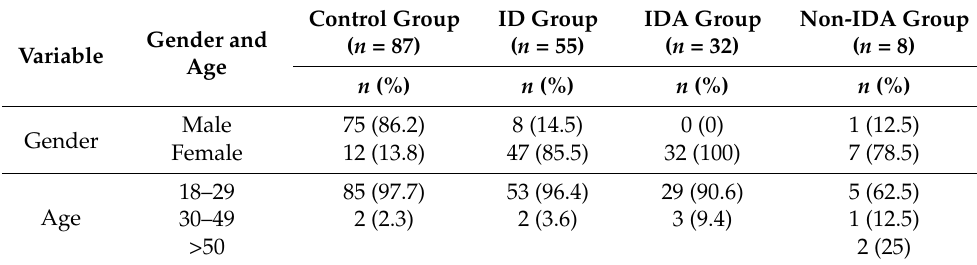
Table 1. Participants demographic data in all four